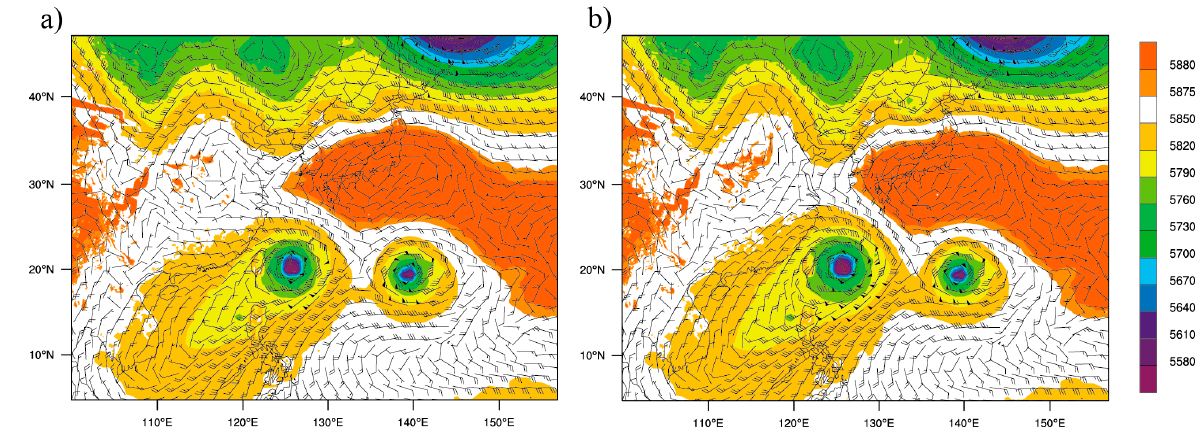
Figure 11. The geopotential height (shaded, units: gpm) from ( a ) the background and ( b ) the analysis at 500 hPa, and wind (wind shaft, units: m/s) in the background at 0600 UTC 8 August 2019.